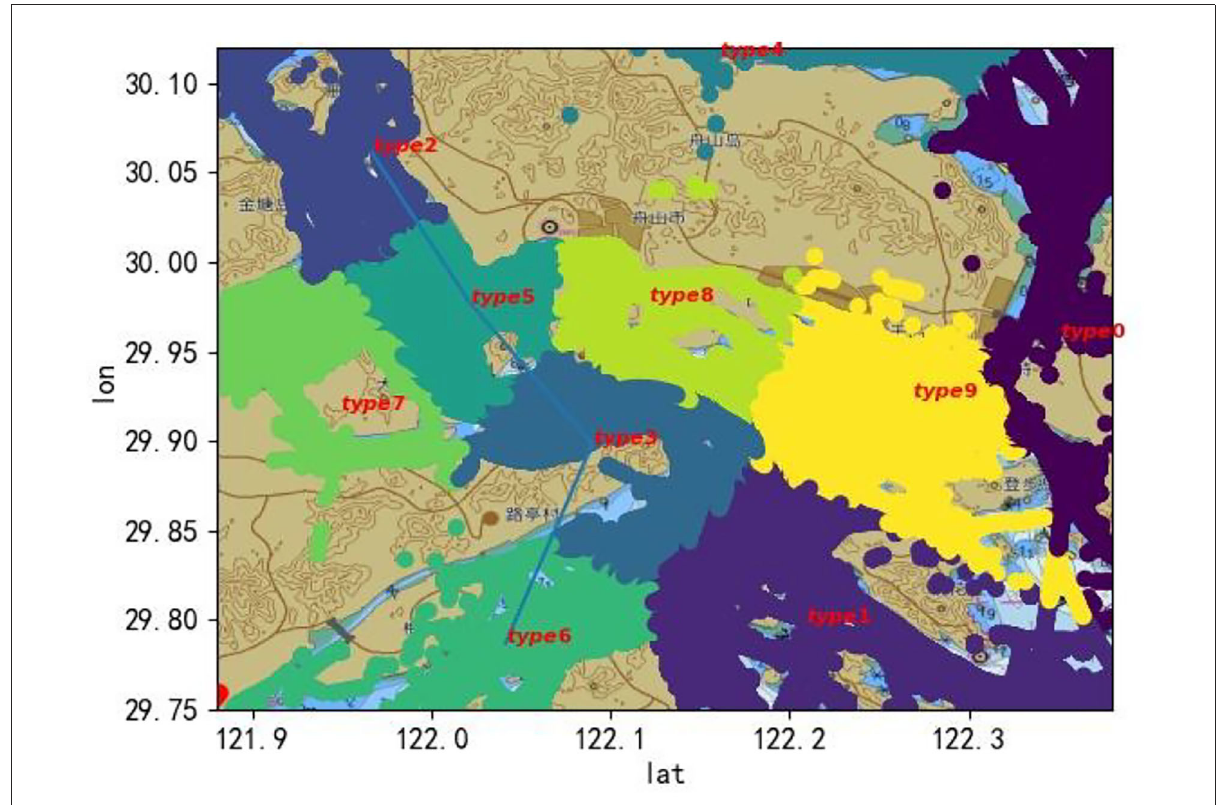
FIGURE5 Clustering map of ship trajectories of a certain day in Dinghai